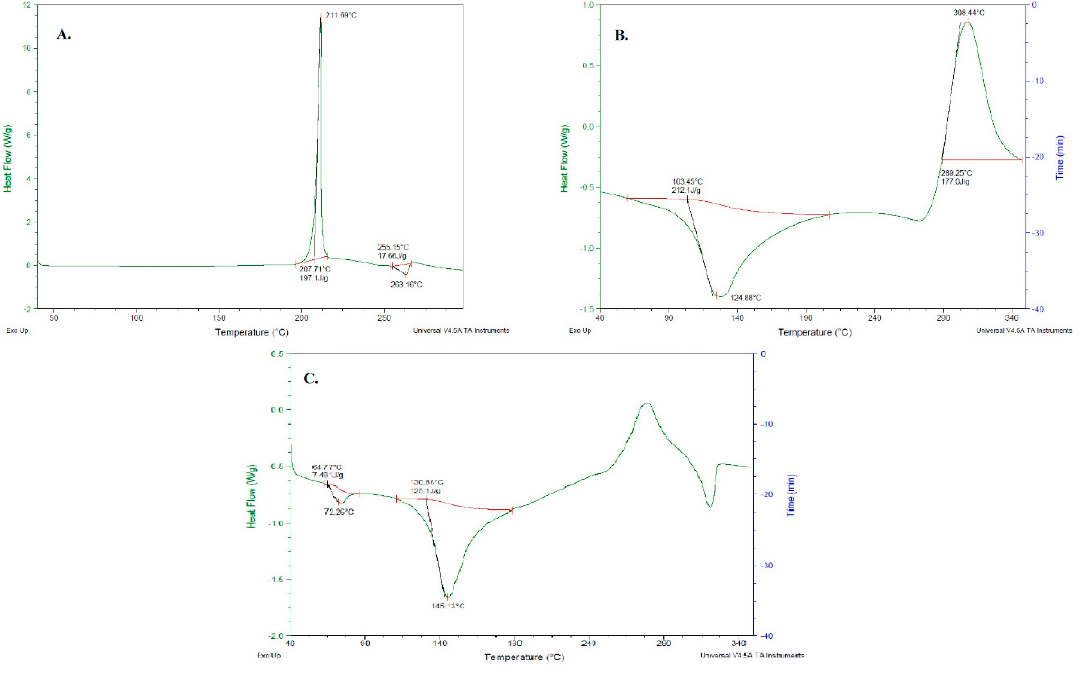
Figure 6. DSC results of ( a ) Ag-FSE, ( b ) CS and ( c ) Ag-FSE CSNPs.